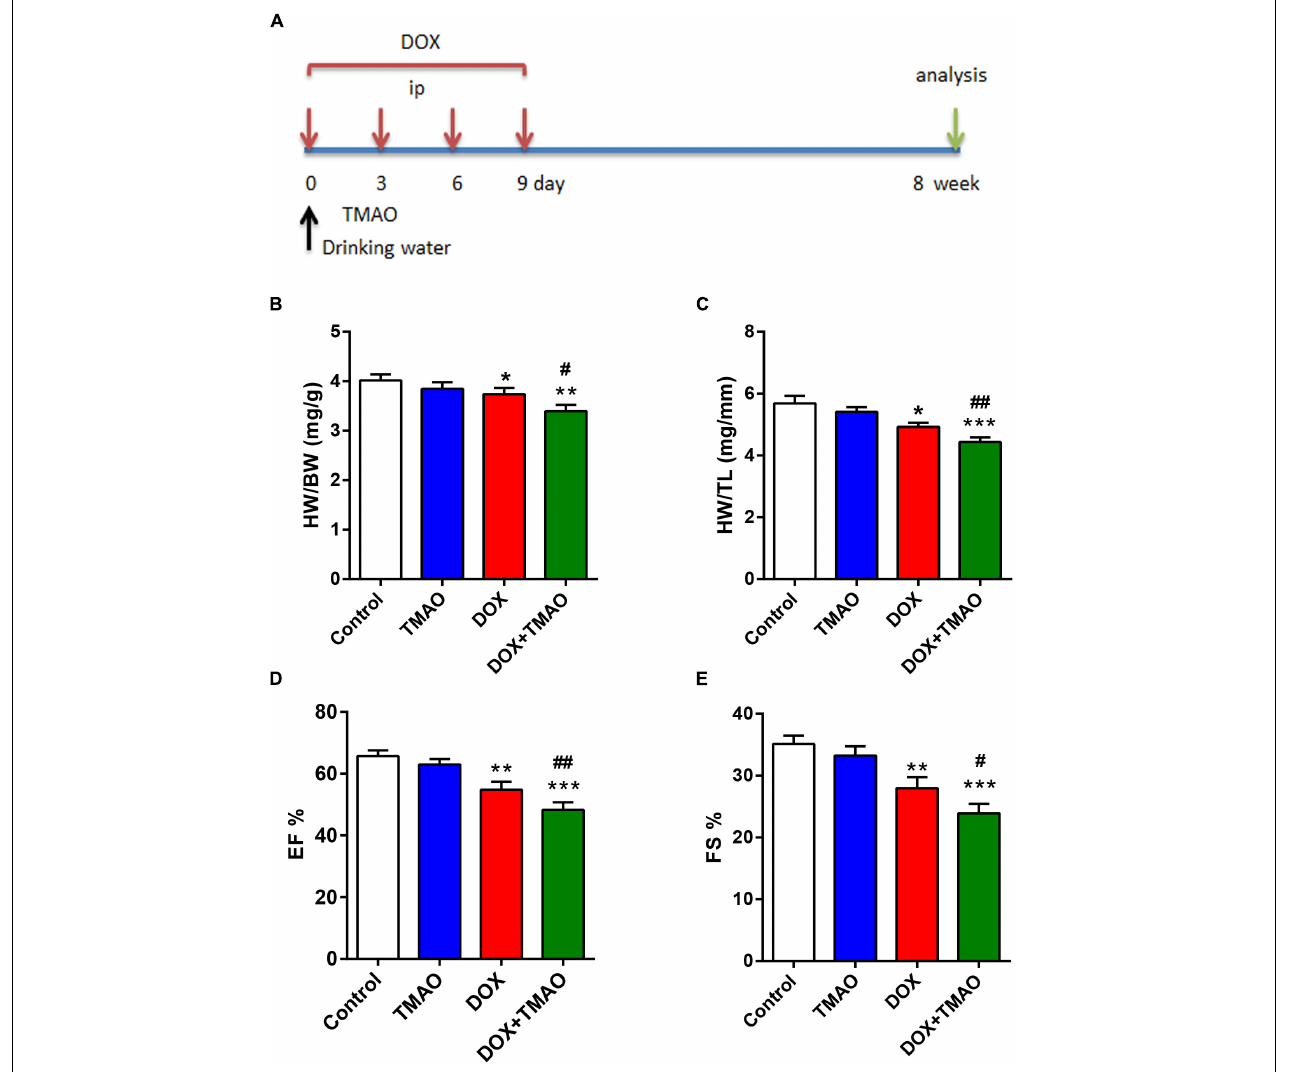
FIGURE 1 | TMAO exacerbated doxorubicin (DOX)-induced cardiac dysfunction. (A) Schedule of the 8-week experiment. The mice received four doses of DOX (6 mg/kg) or PBS every 3 days by intraperitoneal injection (i.p.). Moreover, all mice were treated with or without TMAO (120 mg/kg, 1.60 mmol/l) in drinking water. (B) Heart weight/body weight (HW/BW) and (C) heart weight/tibial length (HW/TL) were analyzed. (D) EF and (E) FS of the mice were measured at 8 weeks. All data were analyzed at least three times. Mean ± SD. ∗ P < 0.05, ∗∗ P < 0.01, ∗∗∗ P < 0.001 (vs. Control). # P < 0.05, ## P < 0.01 (vs.